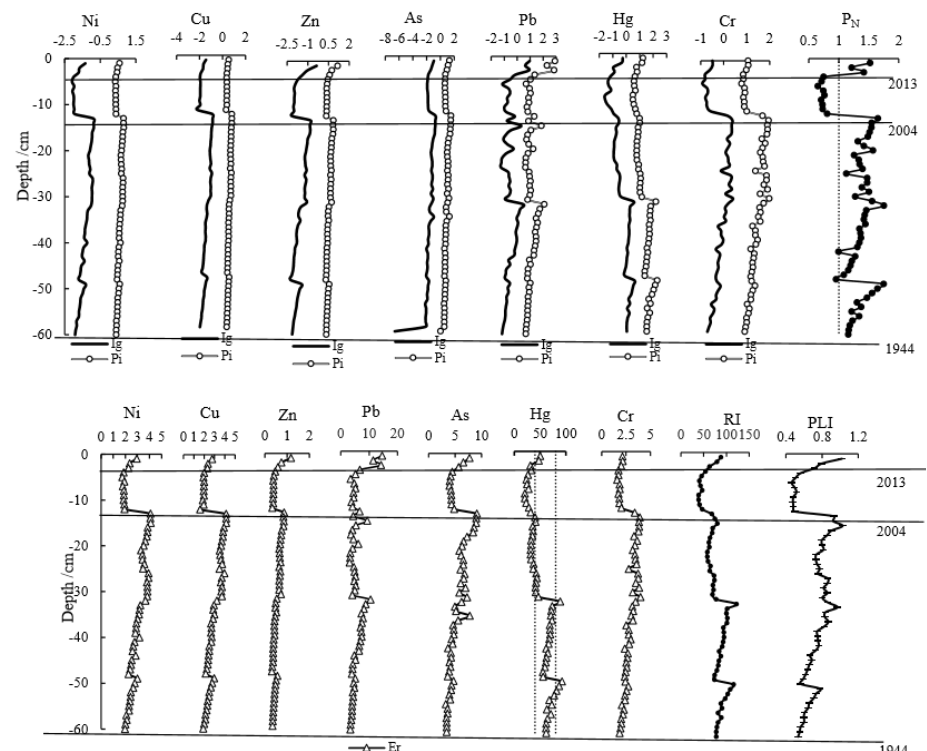
Figure 6. The profiles of the geo−accumulation index ( Ig ), single pollution index ( Pi ), Nemerow index ( P N ), potential ecological risk index ( RI ), and pollution load index ( PLI ) in the sediment